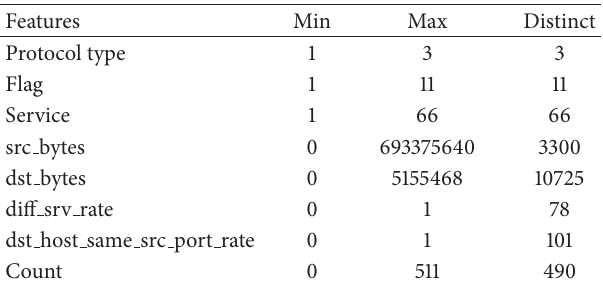
Table 2: Minimum, maximum, and distinct values of some features of KDD